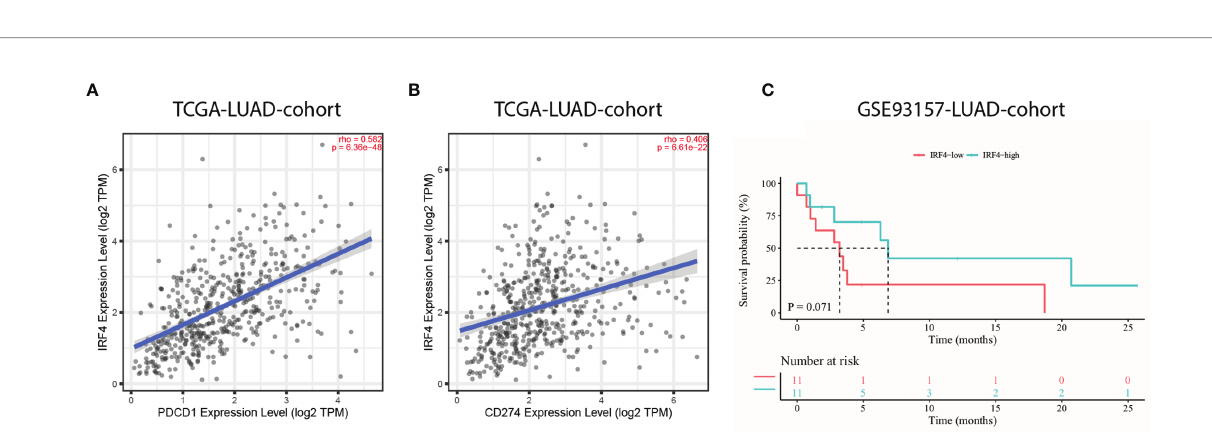
FIGURE 6 | The prognostic value of IRF4 in LUAD patients with immunotherapy. (A, B) . Correlation of IRF4 expression with PDCD1 (A) and CD274 (B) expression in TCGA-LUAD cohort (n = 515). (C) Survival curves of progression free survival based on IRF4 expression in GSE93157-LUAD-cohort (n = 22). LUAD, Lung